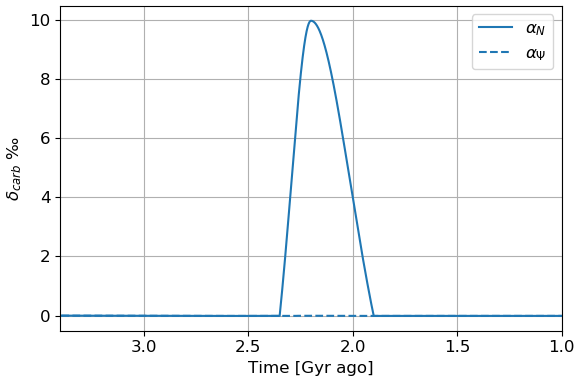
Figure 19. Temporal evolution of δ carb . Models with α N reaching a factor of 2 and α (cid:57) reaching a factor of